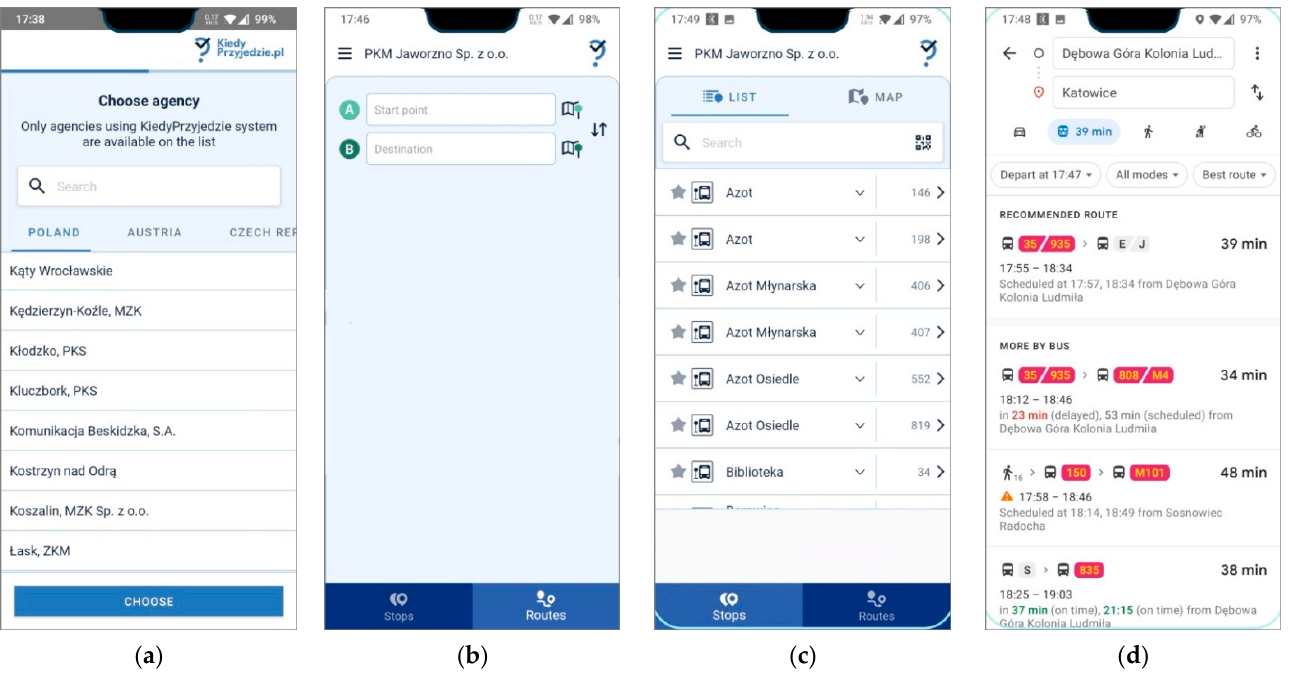
Figure 3. Overview of the Jakdojade application tabs: ( a ) selection of starting points and destina- tions; ( b ) options for selecting the type of route, means of transport and public transport operators; ( c ) routing options; ( d ) detailed information on the selected route.